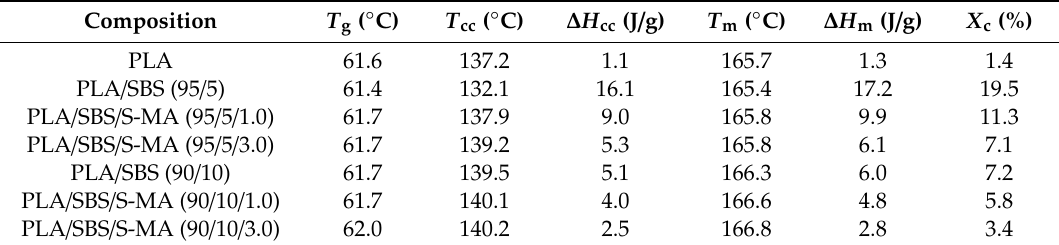
PLA / SBS / S-MA (95 / 5 /